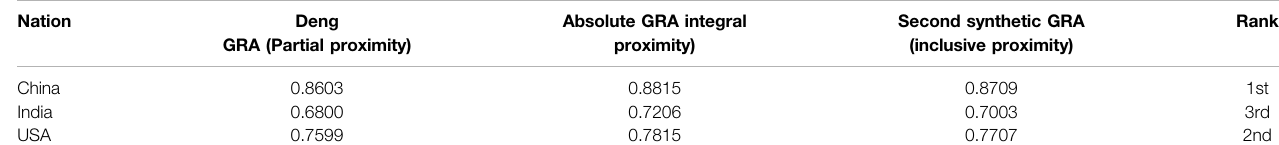
TABLE 5 | Grey relational assessment for solar energy generation and CO 2 emission.